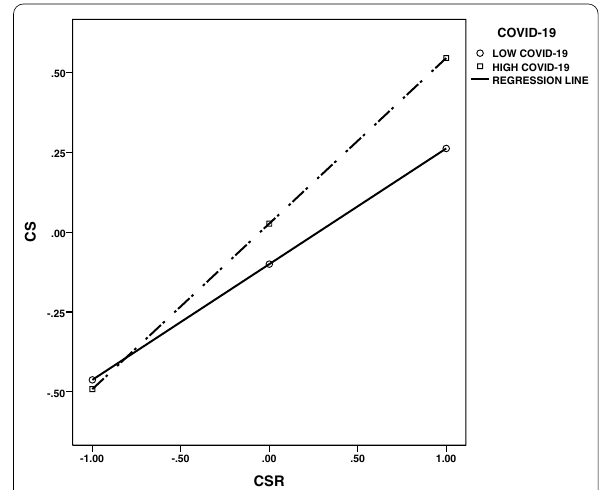
Fig. 3 The moderating effects of COVID-19 between CSR and CS